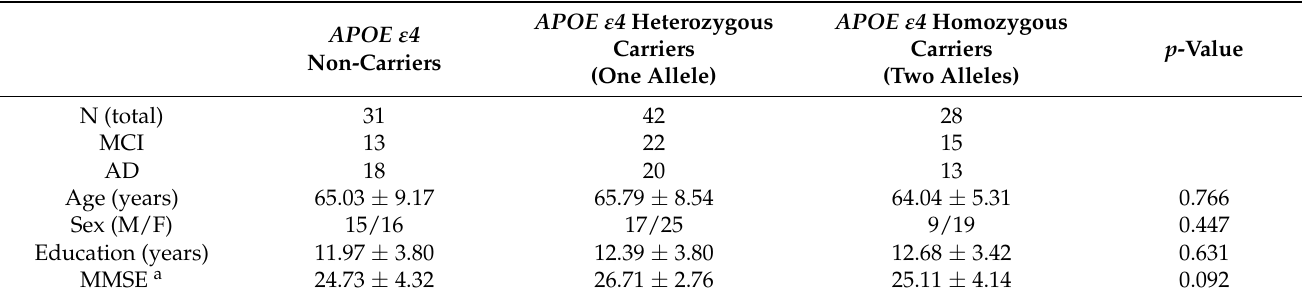
Table 1. Demographic and clinical characteristics in APOE ε 4 non-carriers and